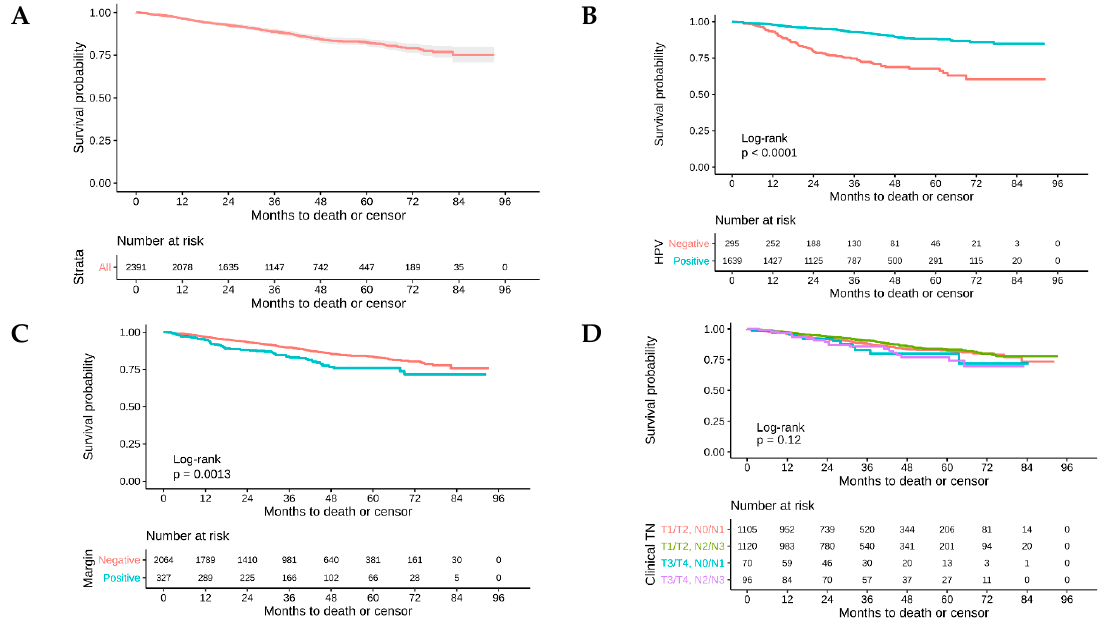
Figure 2. Overall survival in Trans-Oral Robotic Surgery (TORS)-treated patients for ( A ) the entire cohort, ( B ) by human papillomavirus (HPV) status, ( C ) by surgical margin status, and ( D ) by